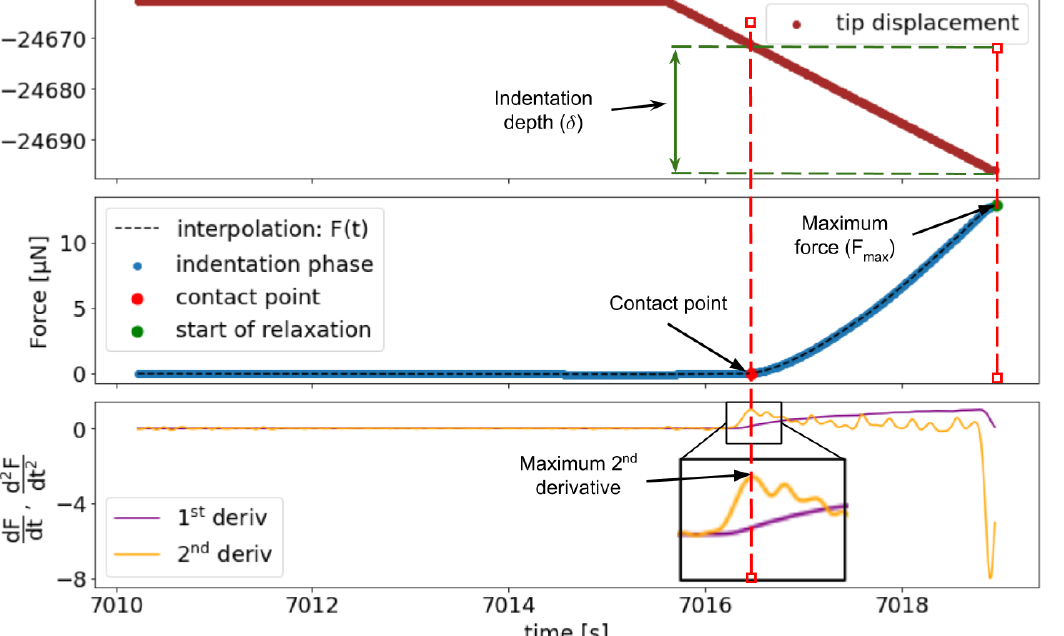
Figure A2. Correction for displacement of the indentation tip. A ) FD curve representative of the indentation of glass (indentation of 100 µm/s and a frequency of data acquisition of 100 Hz). B ) Hertz model and Hook model fittings of glass indentation data. C ) comparison between the FD curve of the indentation of a PAM hydrogel measured immersed in ddH 2 O + 0.1% Extran (blue